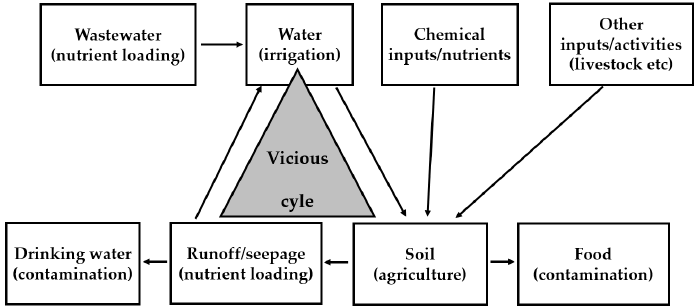
Figure 1. Vicious cycle of eutrophication and its relationships with human activities and environmental impacts.